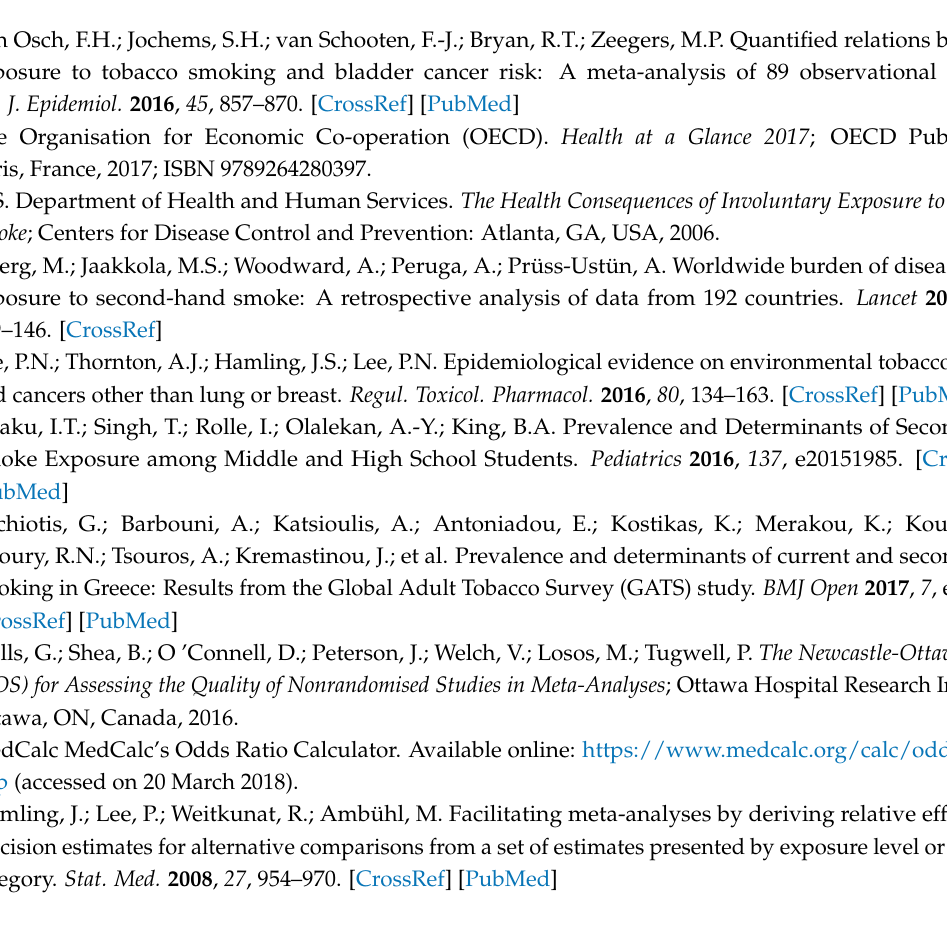
Figure S1: Funnel plots showing risk estimates from individual studies relative to the pooled OR for both analysis on childhood exposure to ETS and adulthood exposure to ETS (both males and females), Figure S2: Meta-analysis results showing pooled risk estimates for UBC stratified by timing (childhood or adulthood) and location (work-related or domestic) of exposure to ETS for males and females combined, only for case-control studies. Author Contributions: Frits H. M. van Osch prepared the manuscript and performed the analysis. Frits H. M. van Osch and Sylvia H. J. Jochems did the article selection and data extraction. Maurice P. Zeegers, Frederik J. van Schooten and Richard T. Bryan were involved in conception and design of the research. Anke Wesselius and Richard T. Bryan have substantially revised the work. All authors agreed with the contents of the